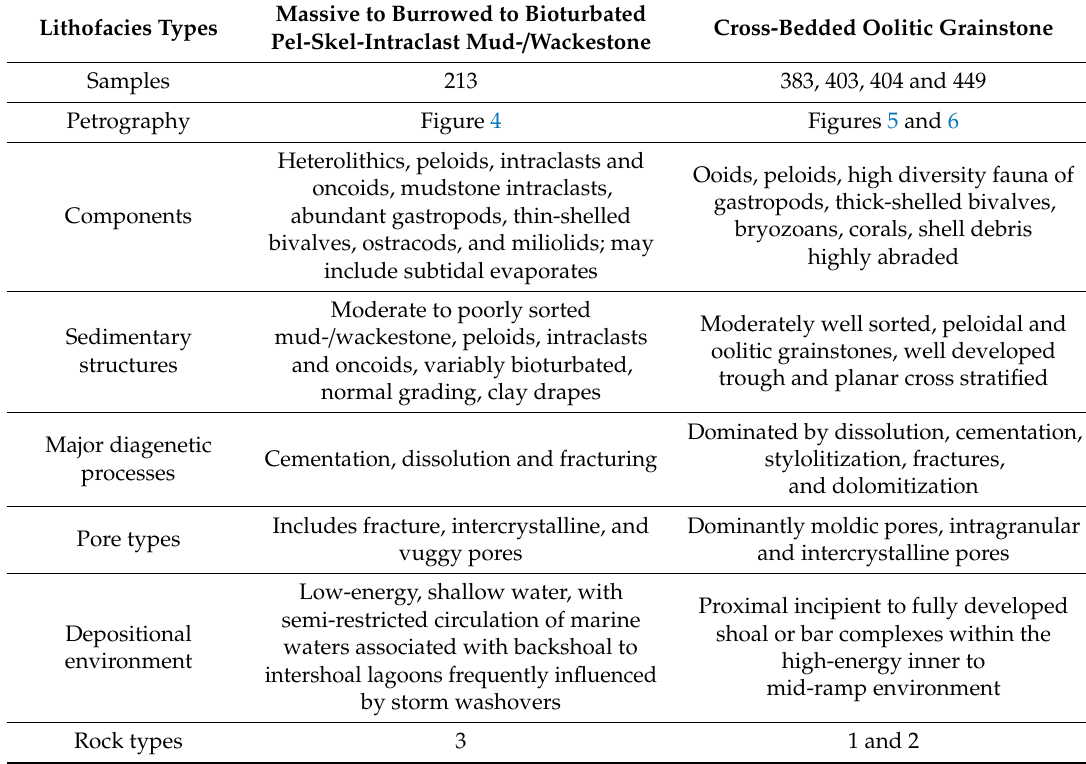
Figure 3. Integrated laboratory analysis workflow for improved rock typing and pore network imaging. Table 1. Description of lithofacies associated with the studied samples derived from Koehrer et al. [22] and observations of this study. For the explanation of rock types, see Section